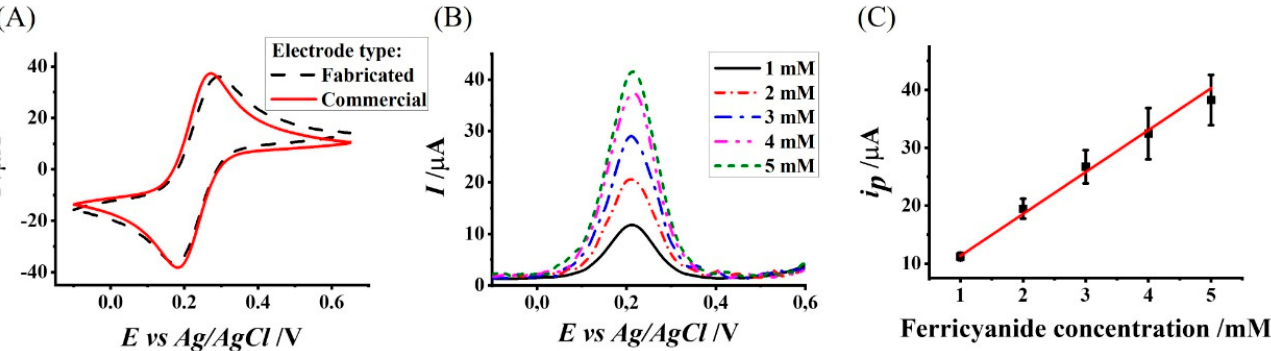
Figure 3. Electrochemical characterization of the microfabricated electrodes. ( A ) Cyclic voltammo- grams recorded using a commercial (solid red) and the microfabricated (dashed black) electrodes in a 5 mM Ferri/Ferro solution. ( B ) Voltammograms recorded in the presence of 1, 2, 3, 4, and 5 mM Ferri concentrations. ( C ) A calibration curve plot of the oxidation peak current as a function of the Ferri concentration recorded using the microfabricated electrode.